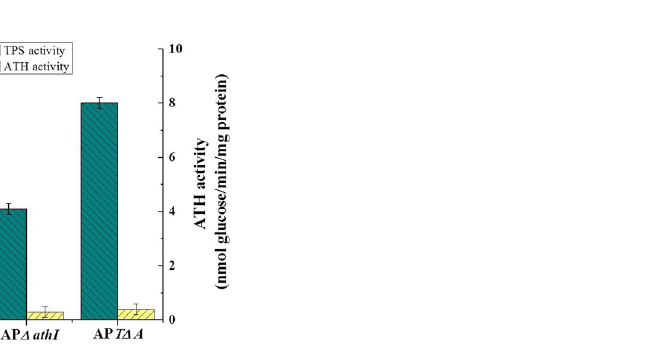
Table 1. Homologues of trehalose biosynthesis enzymes and their identity in A . subglaciale F134.